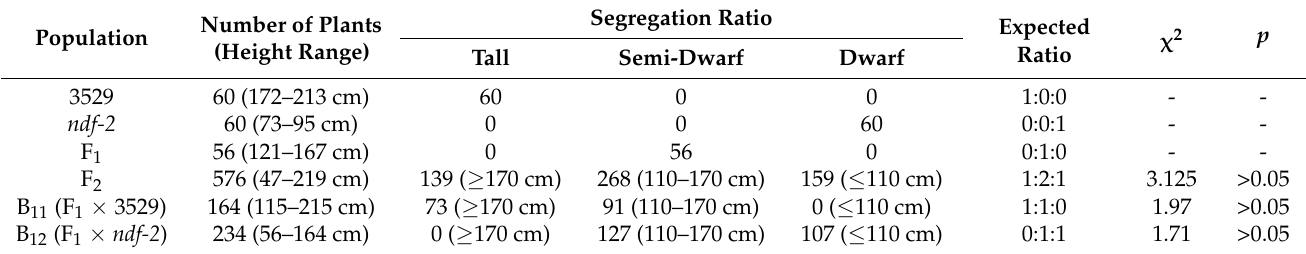
Table 2. Plant heights and Chi-squared test for the segregation ratio of